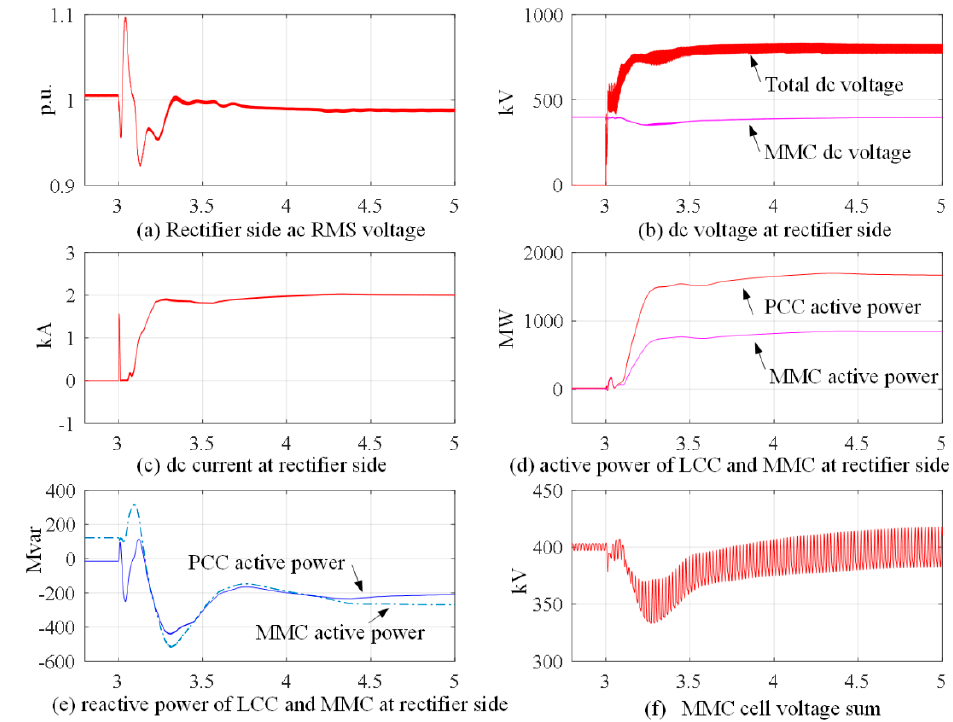
Figure 14. Hybrid HVdc start-up simulation results.